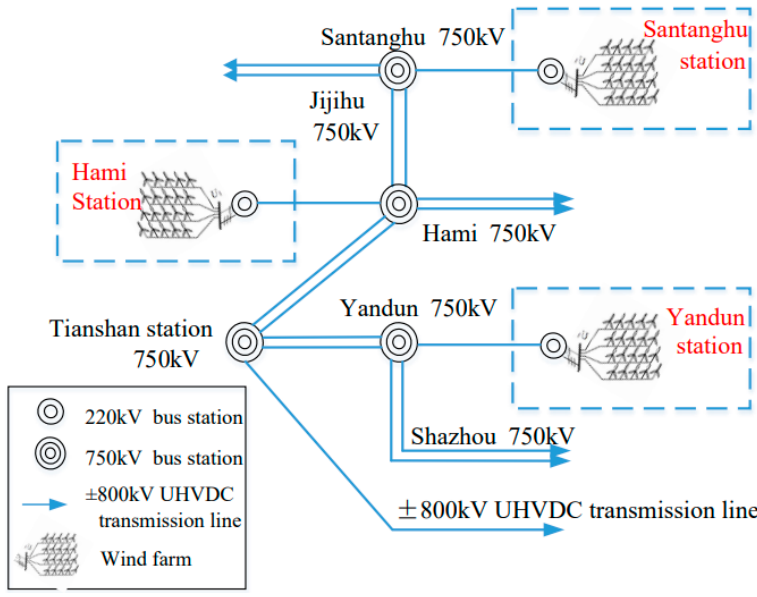
Figure 8. Schematic diagram of Hami power grid.